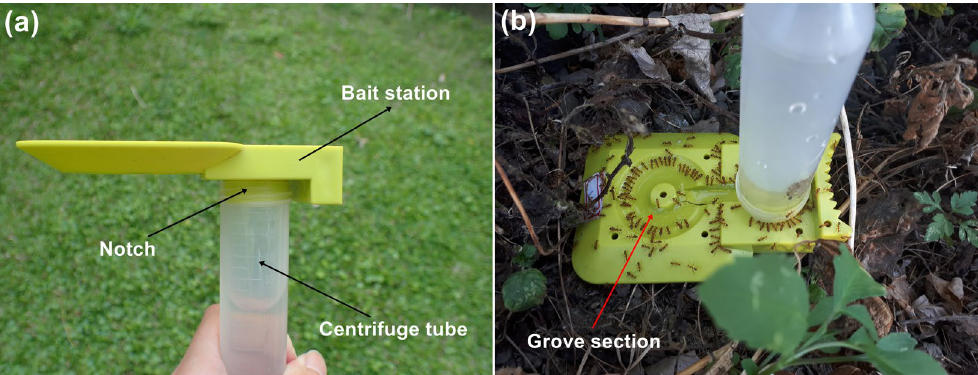
Figure 2. ( a ) Liquid bait station and ( b ) Anoplolepis gracilipes workers feeding on 10% sucrose